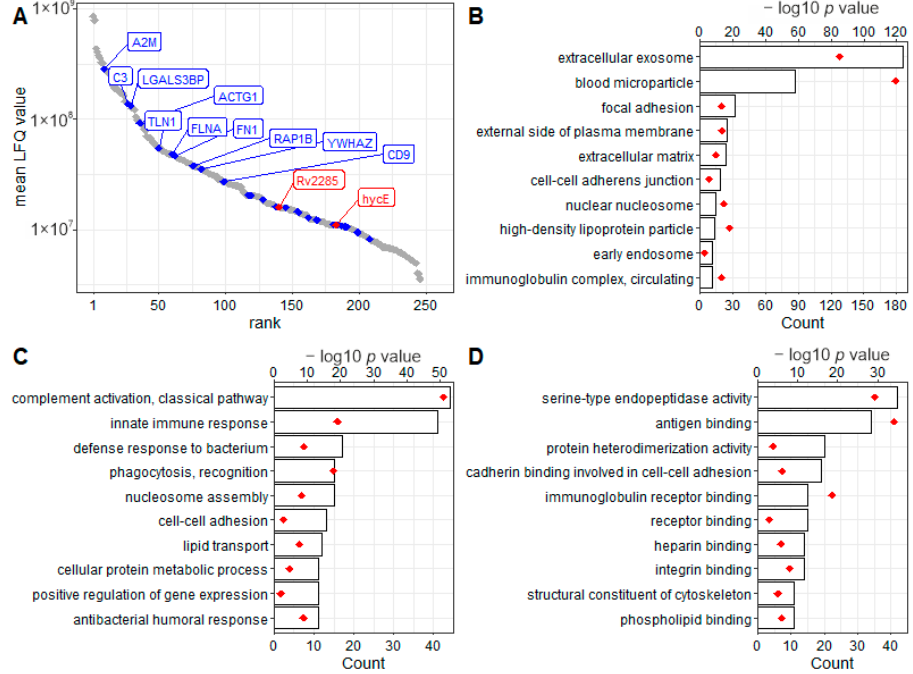
Figure 6. Identification of exosomal proteins by mass spectrometry-based proteomics. ( A ) Proteins were isolated from circulating exosomes, proteolytically cleaved, and analyzed via mass spectrometry-based proteomics. Proteins were identified by MaxQuant (version 1.6.3.3). Protein abundances were estimated by the included MaxLFQ algorithm. Based on label-free quantification (LFQ), isolated proteins span about five orders of magnitude of abundance and include common populations of frequently observed vesicular proteins (blue) and proteins of M. tuberculosis origin (red). Identified proteins were used for gene ontology (GO) overrepresentation analysis, including the categories “cellular components” ( B ), “biological processes” ( C ), and “molecular functions” ( D ). Representative terms are illustrated by the number of included proteins (bars) and the significance of overrepresenta- tion (as-log 10 p value, red